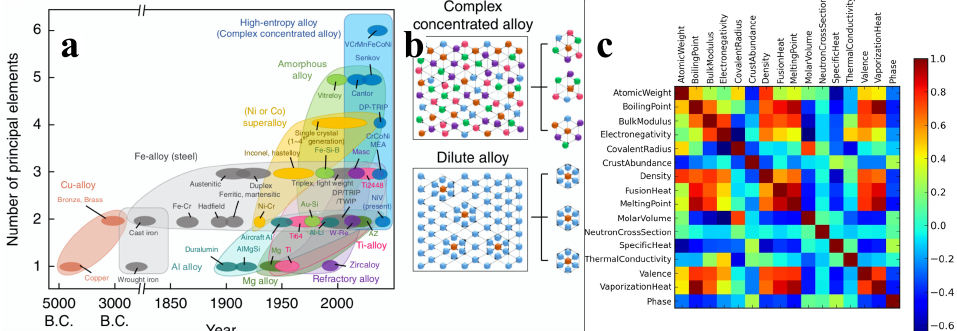
Figure 10. Multi-component solid solution alloys: Solutions for optimal mechanical